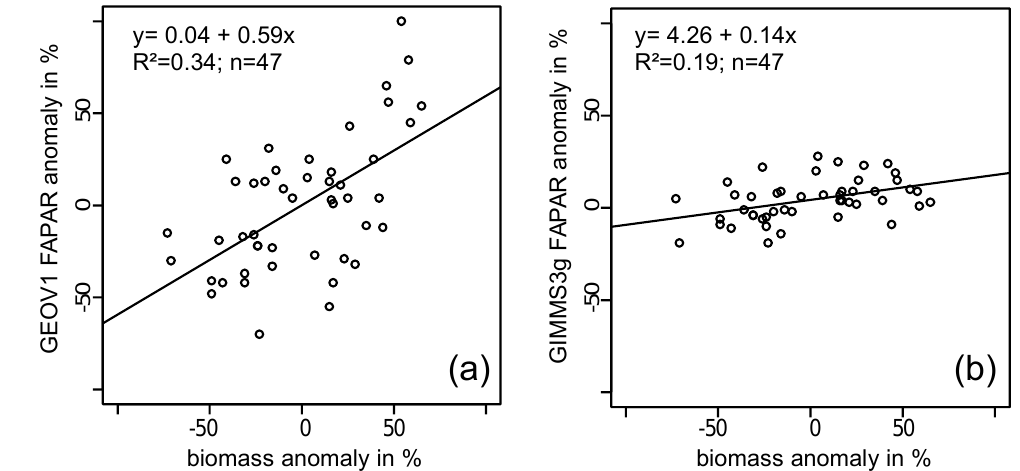
Figure 8. Scatterplots between ground based biomass (sites C3L5 , C2L5 , C2L4 ) and GEOV1( a )/GIMMS3g ( b ) pixel values obtained over the monitoring sites from 1987 to 2010. The relationships are not strong, but highly significant ( p ≤ 0.01). Inter-annual discrepancies between observed biomass and satellite derived FAPAR are high, thus neither GEOV1 nor GIMMS3g FAPAR are robust proxies for biomass